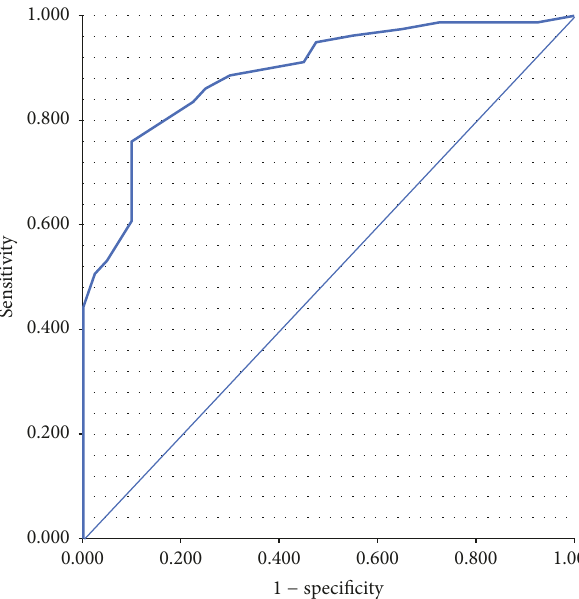
Figure 2: ROC curve. Diagonal segments are produced by